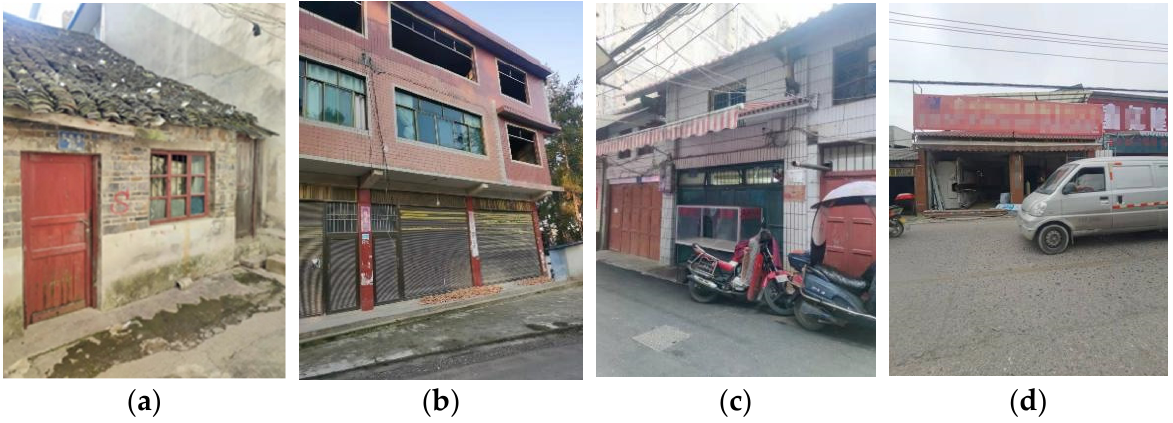
Figure 1. Four types of IS in China. ( a ) Old communities, where the main body of the building was made of bricks. ( b ) Informally constructed settlements, where the buildings were constructed without official approval. ( c ) Informally modified settlements, where the additional decoration of the roof was private and illegal. ( d ) Informally functioned settlements, where the functions of accommodation, production, storage and business were mixed.